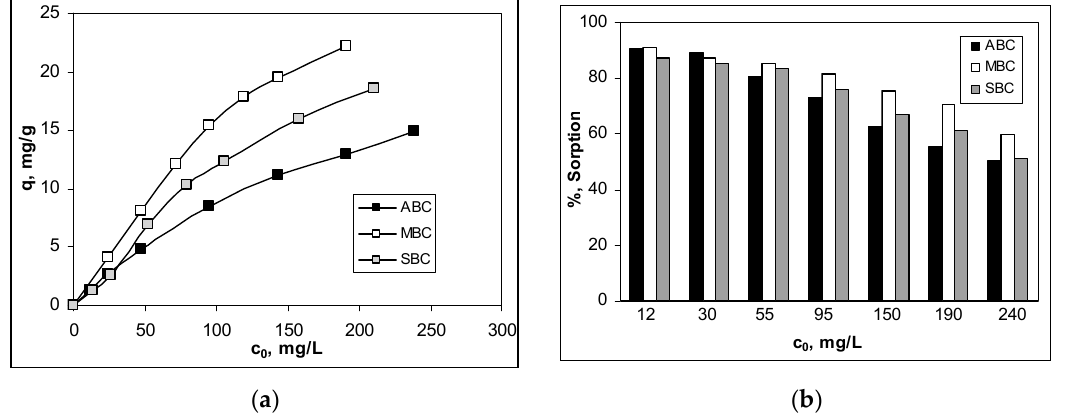
Figure 3. Effect of initial Co(II) ions concentration on sorption capacity ( a ) and sorption efficiency ( b ) on the three types of biochars (Experimental conditions: Initial pH = 5.0; biochar dose = 8 g/L; contact time = 24 h; temperature = 25 °C).